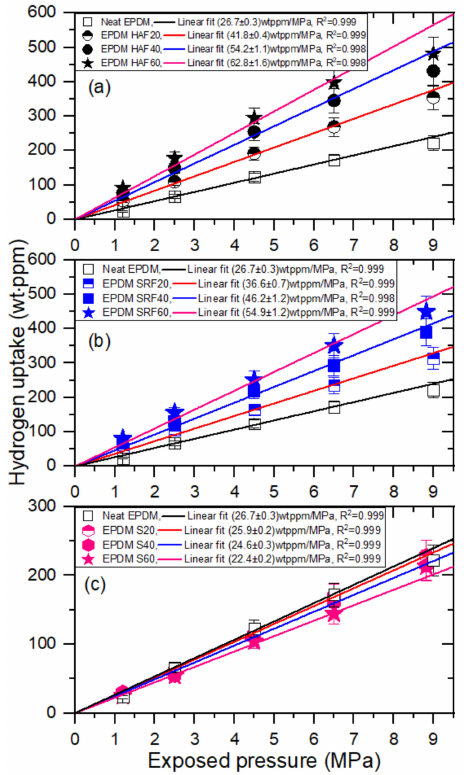
Figure 4. Hydrogen uptake ( C ∞ ) versus exposed pressure for the ( a ) EPDM HAF series, ( b ) EPDM SRF series, and ( c ) EPDM silica series. The lines indicated, as the slope of hydrogen uptake with respect to pressure, with a squared correlation coefficient R 2 , are the result of Henry’s law